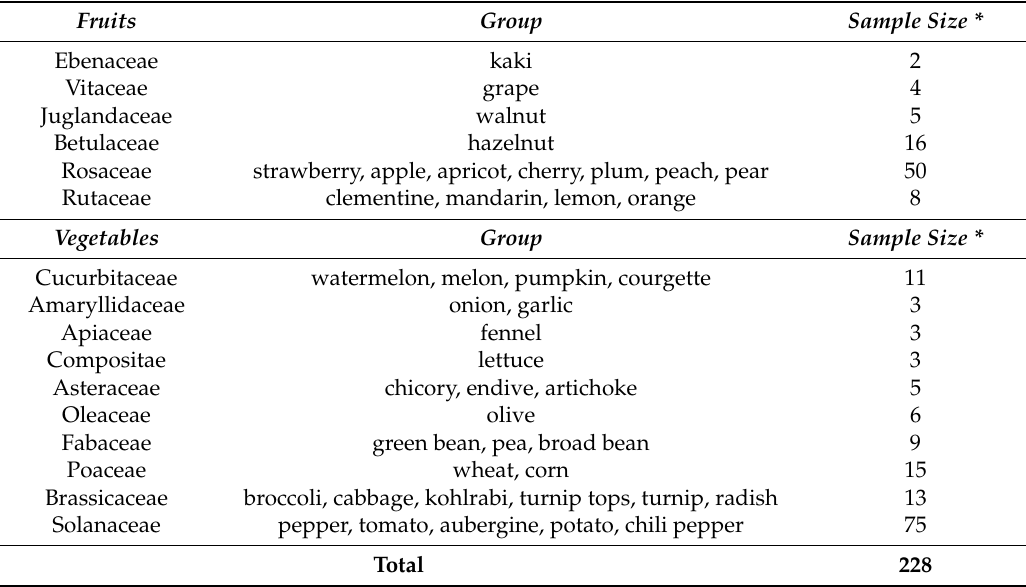
Table 1. Fruit and vegetable samples analyzed in this study.